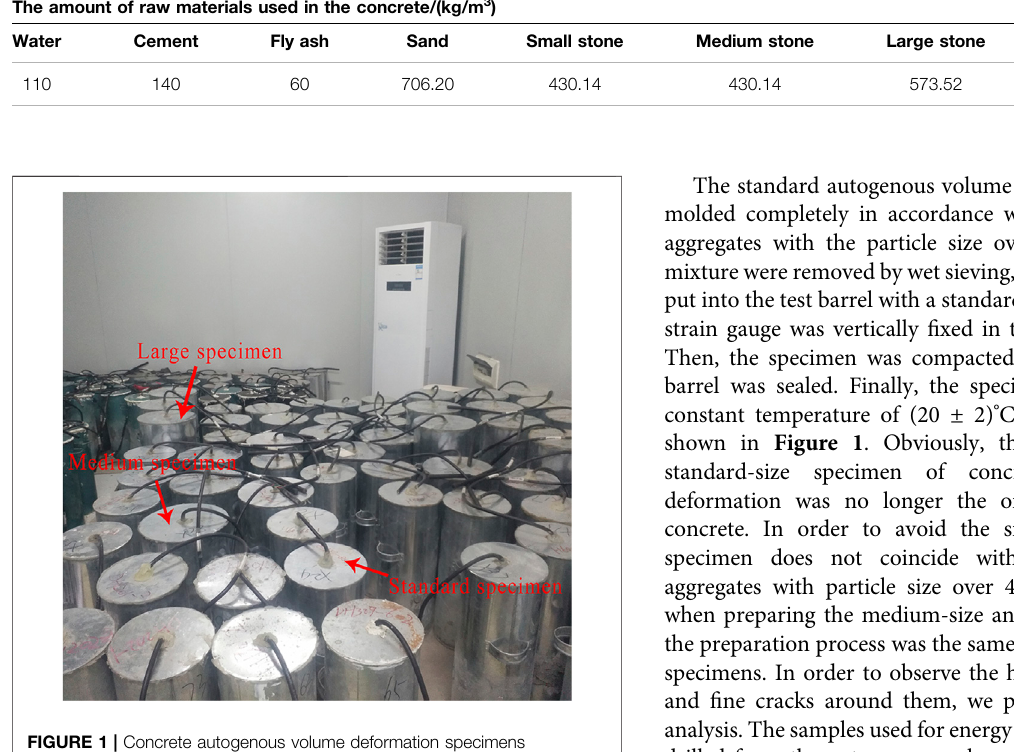
FIGURE 1 | Concrete autogenous volume deformation specimens placed in the lab with constant temperature and isolated humidity.